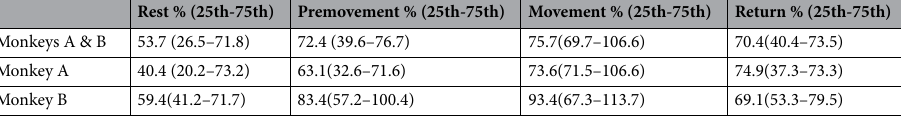
Table 4. Electrical charge delivered in aDBS during the Rest, Premovement, Movement, and Return periods relative to that in cDBS. Percentage ratios and ranges (25th-75th percentile) to values in cDBS were